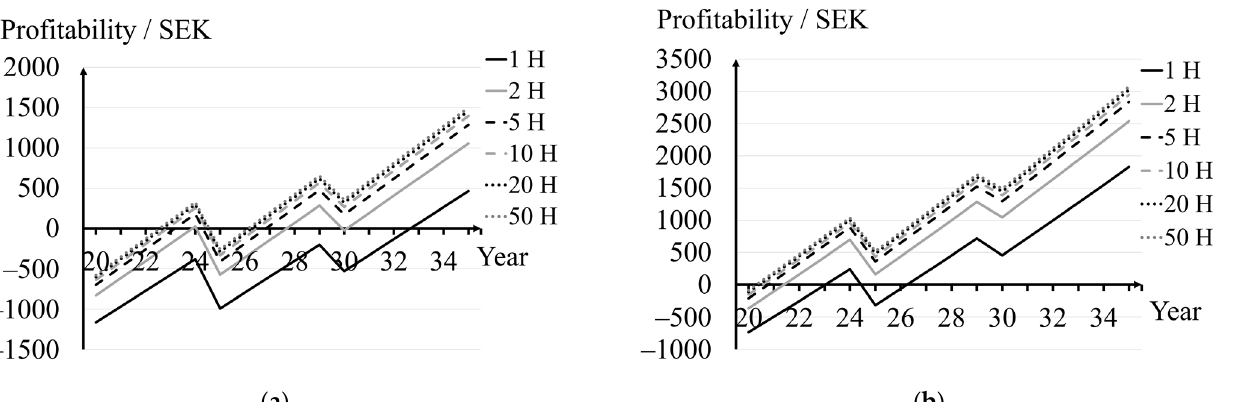
Figure 11. ( a ) Average household profitability over the years with a 0.25 kWp PV system and considering electricity price growth of 2%; ( b ) average household profitability over the years with a 0.25 kWp PV system and considering electricity price growth of 3%; The term “household” is denoted H in the graphs.